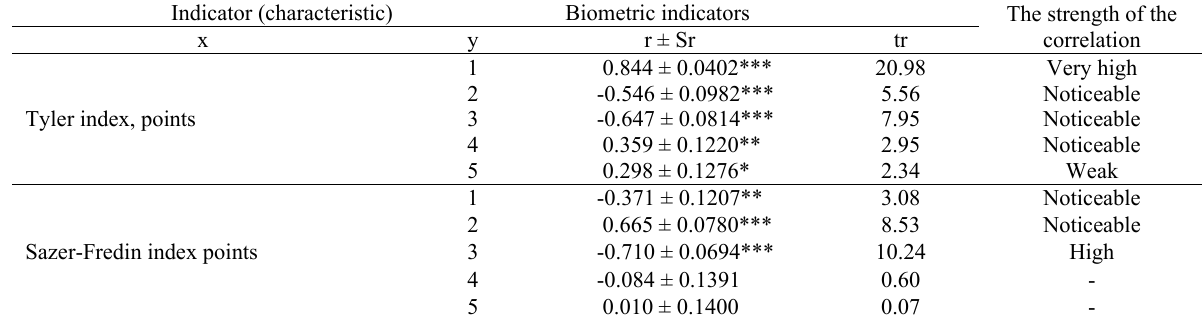
Coefficients of pair correlation between fattening and meat qualities of young pigs and evaluation indices Indicator (characteristic) Biometric indicators The strength of the